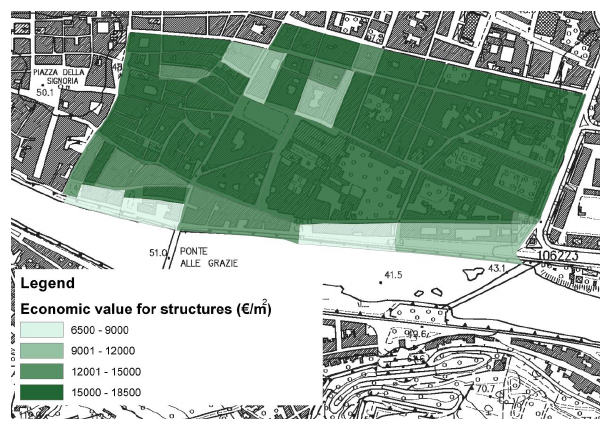
Figure 11. Map of the monetary value for structures (€/m 2 ) referred to census section unit 2 Fig. 11. Map of the monetary value for structures (Cm − 2 ) referred surface. 3 to the census section unit surface.